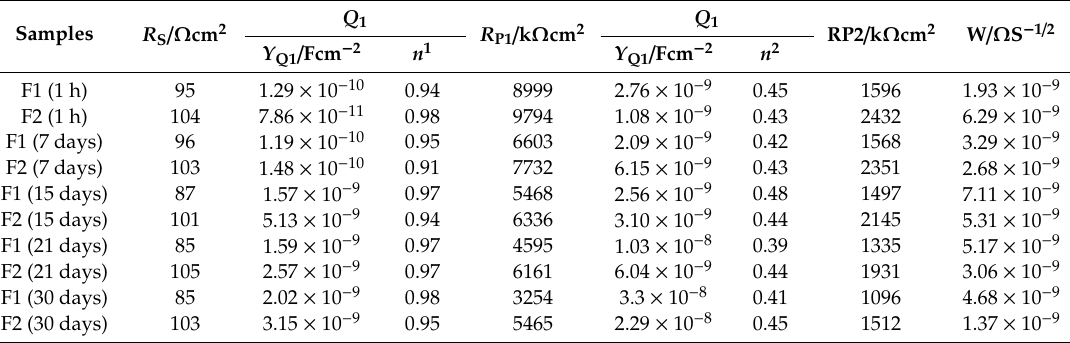
Figure 11. The equivalent circuit model used to fit electrochemical impedance spectroscopy (EIS) data. Table 5. EIS parameters obtained by fitting the Nyquist plots for the di ff erent epoxy coatings immersed in 3.5% NaCl solutions for varied exposure